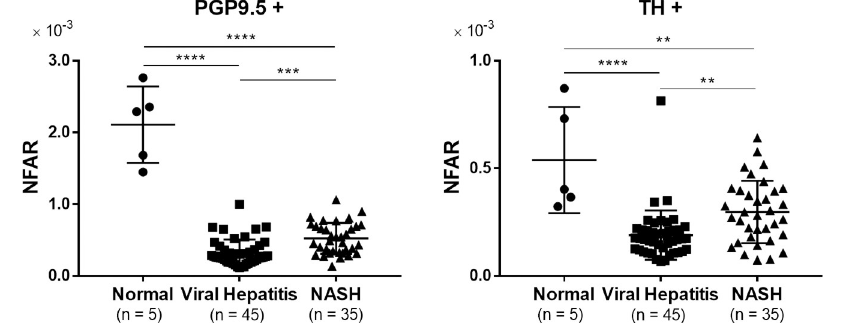
Fig 2. Comparison of NFAR among liver diseases. Comparison of NFAR for whole nerve fibers (PGP9.5+) and sympathetic nerve fibers (TH+). Data were analyzed by one-way ANOVA and Tukey’s multiple comparison test. �� P < 0.01, ��� P < 0.001, ���� P <